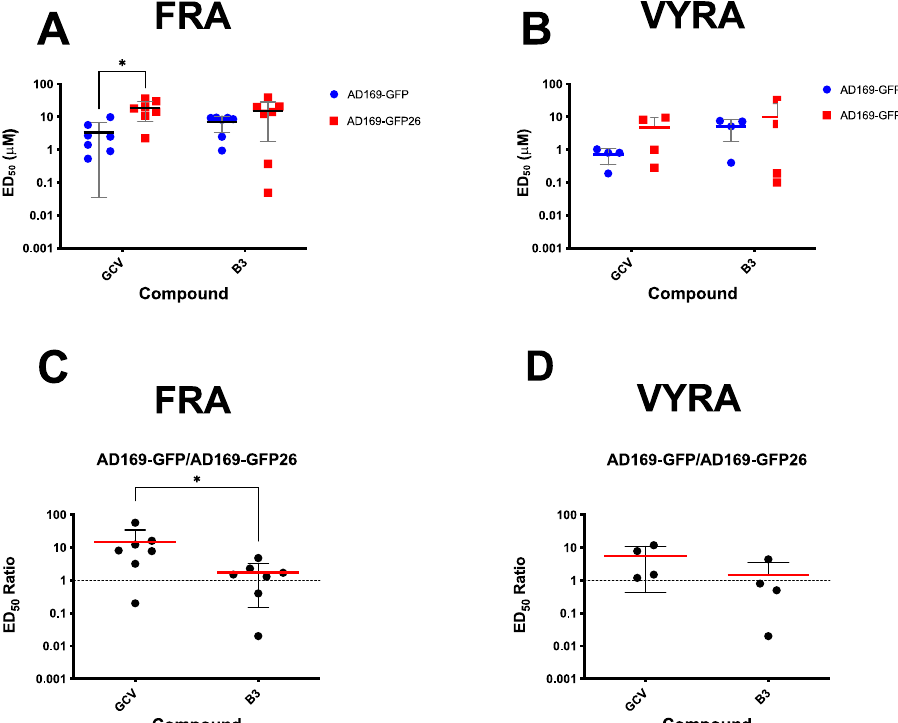
Figure 6. B3 efficiently inhibits replication of the GCV-resistant AD169-GFP26 virus. MRC5 were infected with either AD169-GFP virus or its GCV-resistant counterpart AD169-GFP26 at a MOI of 0.05 IU/cells and treated with increasing concentrations of the indicated compounds. At 7 days p.i., cells were lysed and plates processed for FRAs ( A , C ), while supernatants were collected and used for VYRAs ( B , D ). For the latter experiments, MRC5 cells were infected with serial dilutions of supernatants derived from infected cells. At 7 days p.i., viral titers were calculated using the TCID 50 method. Data from both assays were used to calculate the ED 50 relative to the two viruses ( A , B ) as well as the ratio between the ED 50 calculated for AD169-GFP26 and AD169-GFP ( C , D ), for both GCV and B3. Data shown are single measurements, means, and standard deviation of the mean relative to at least three independent experiments (see Table 1), along with the p -value relative to the Student’s t -test the indicated groups; *: p ≤ 0.05. Table 1. Summary of FRA and VYA for AD169-GFP and AD169-GFP26.